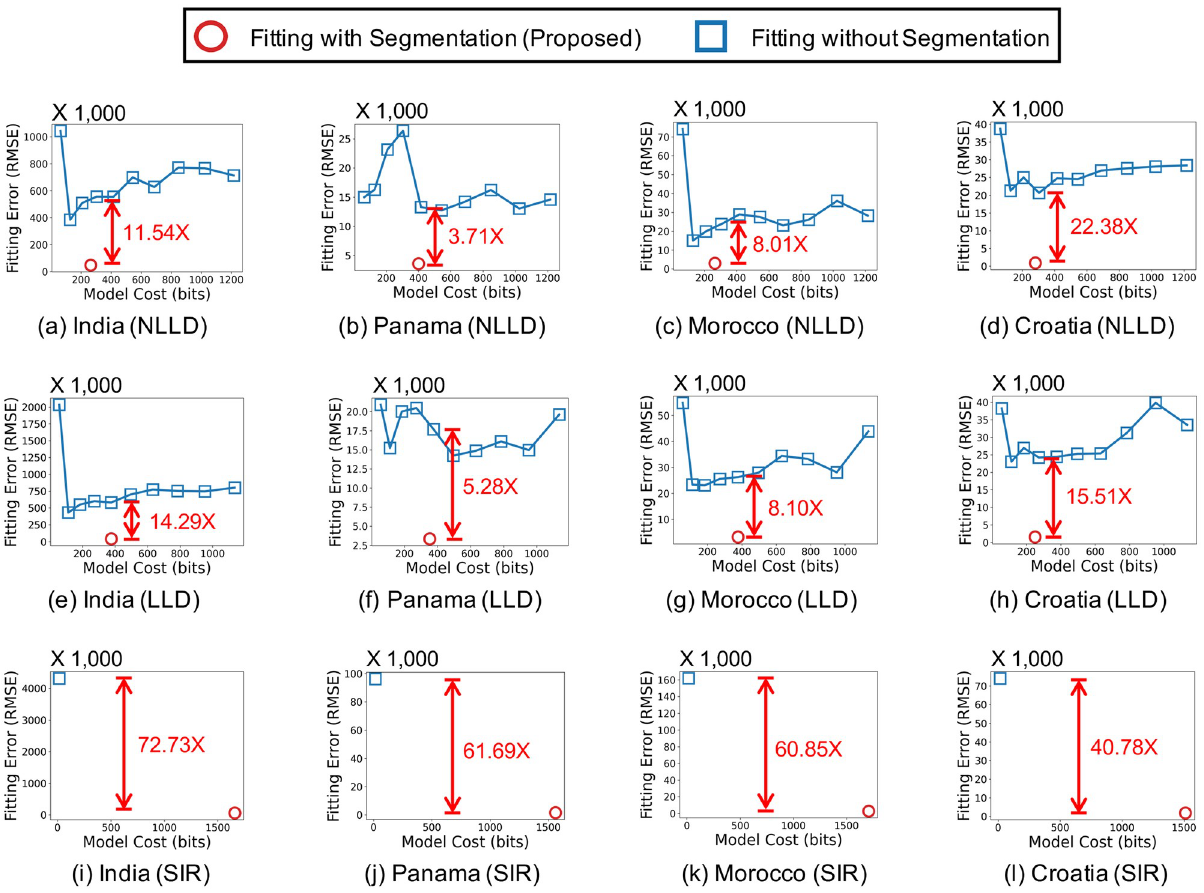
Fig 2. Segmentation leads to better trade-offs between model complexity and fitting error. For the LLD and NLLD models without segmentation, k varies from 1 to 10.